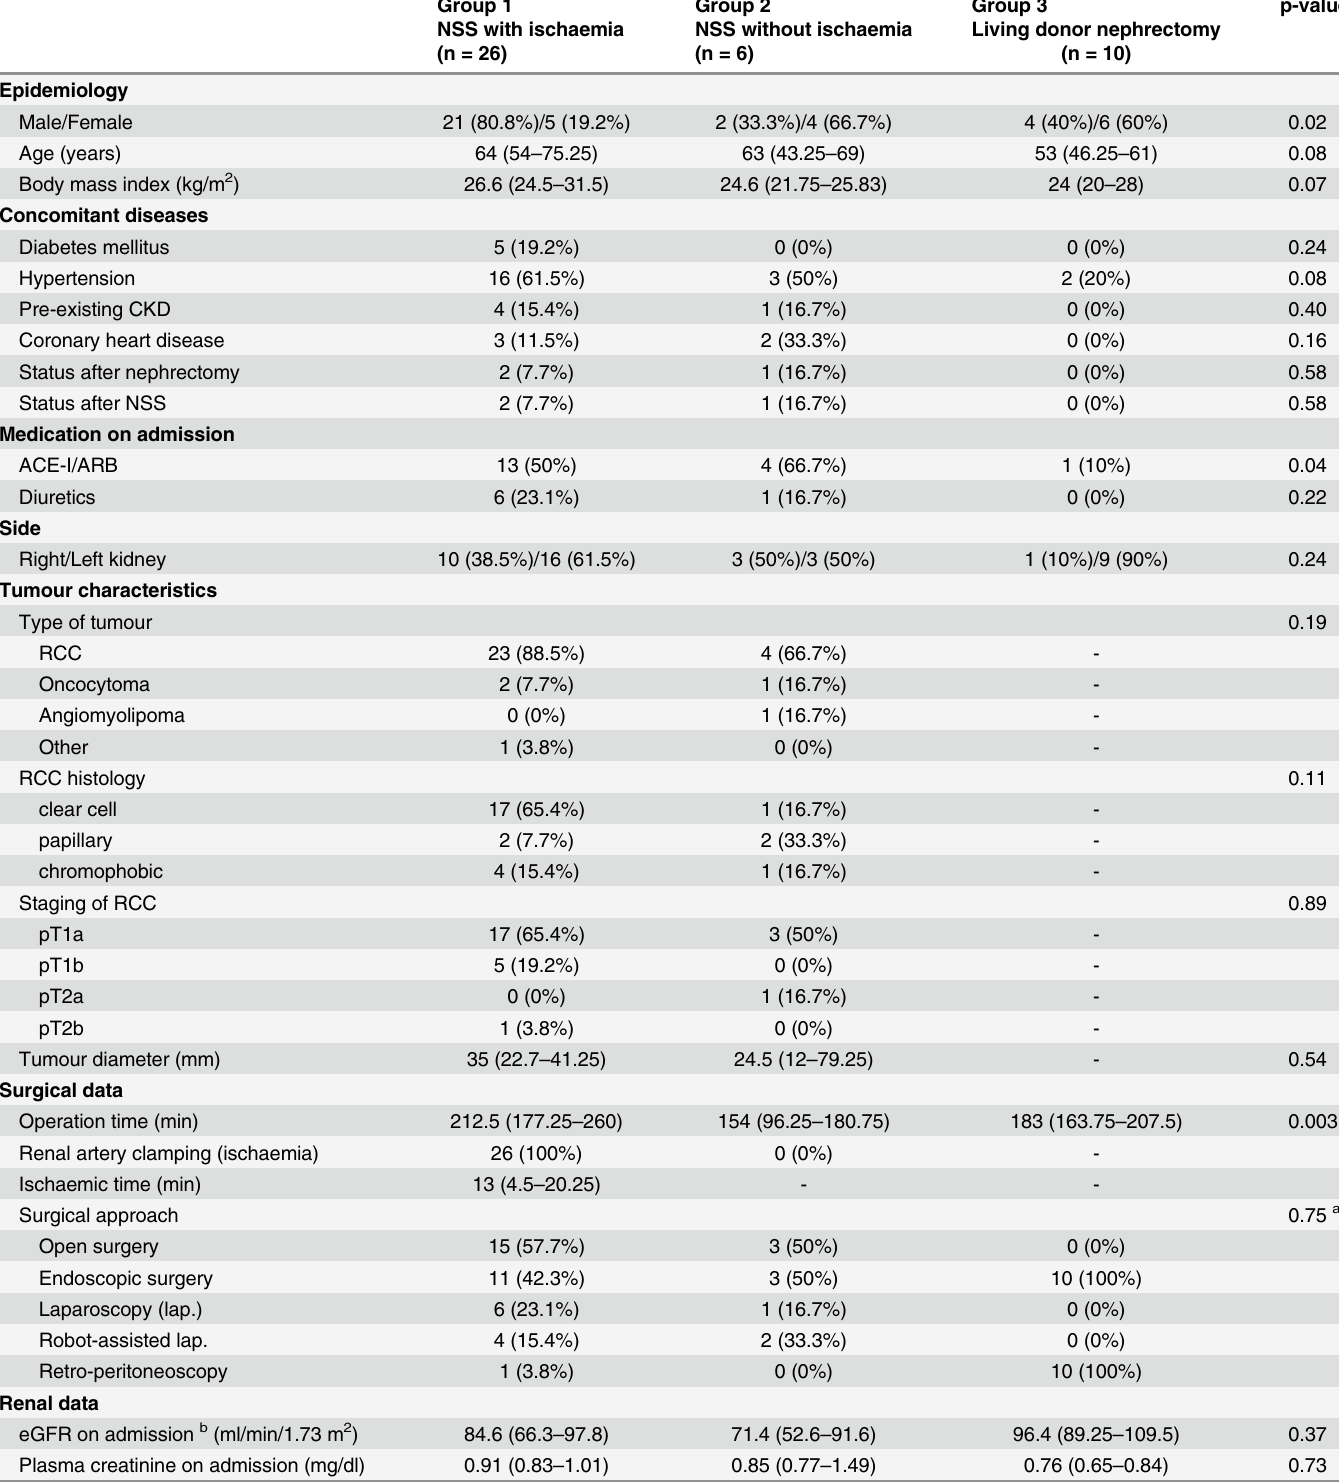
Table 1. Epidemiological data, concomitant diseases, tumour characteristics, surgical data, renal parameters, and baseline urinary calprotectin/ NGAL concentrations in the study